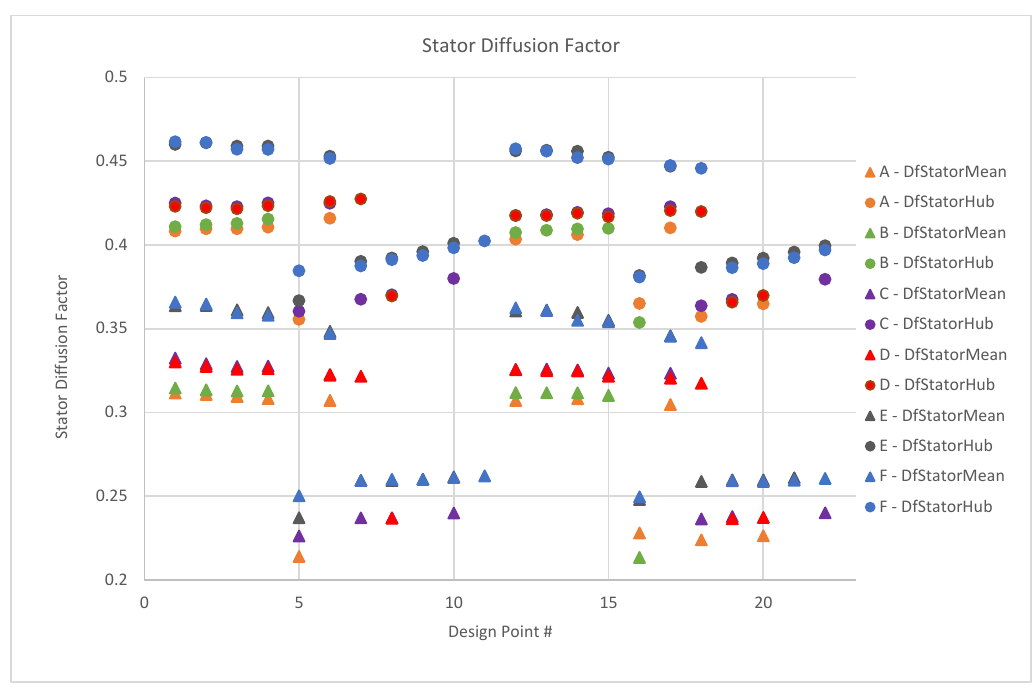
Table 13. Preliminary blade parameters. Figure 22. Variations in the stator diffusion factor with the different stator blade parameters. Design points 5 and 16 (DP5 = HtrInlet = HtrOutlet = 0.56–DP16 = HtrInlet = 0.56, HtrOutlet = 0.57,